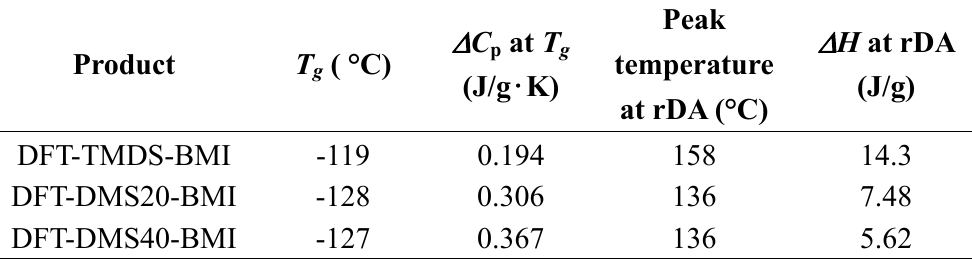
Table 3. Thermal property data drawn from the DSC